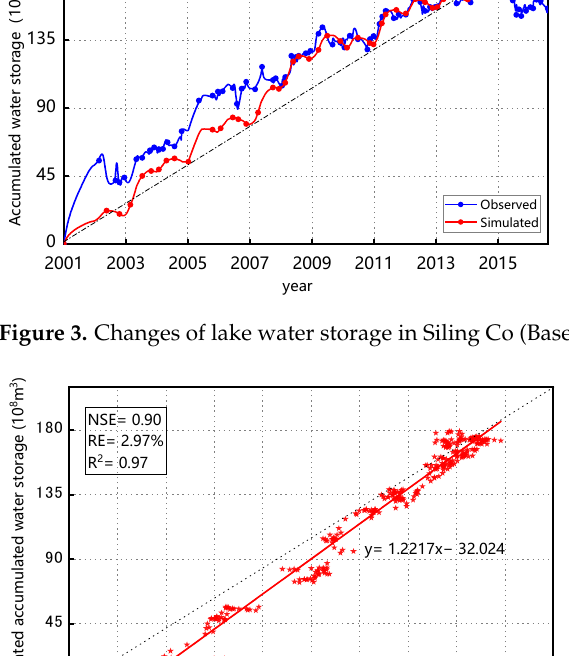
Table 3. Simulation efficiency and evaluation index in different period.